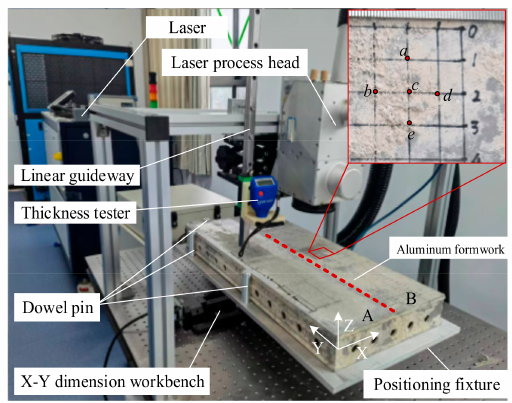
Figure 3. Laser cleaning test and detection